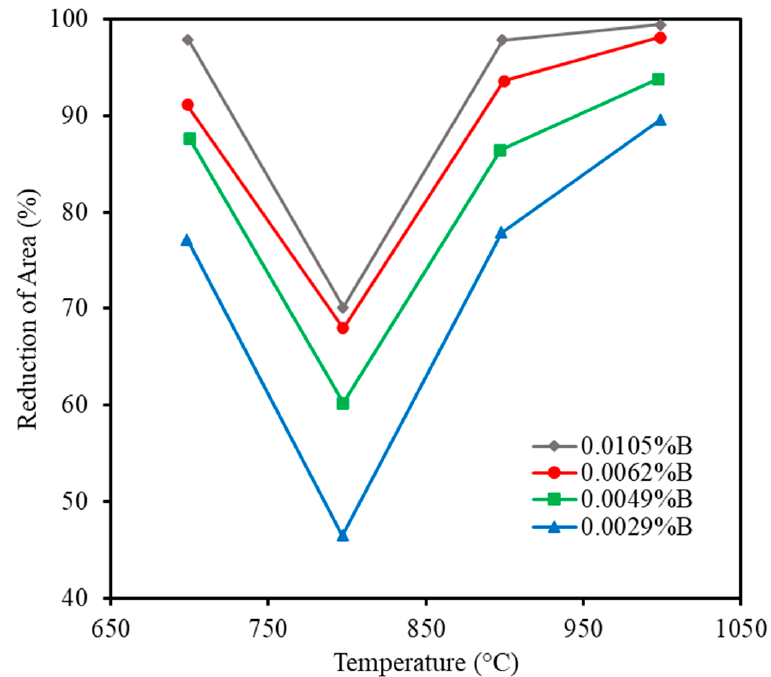
Figure 5. Hot ductility curves for a series of plain C-Mn steels with varying amounts of boron, from 0.0029 to 0.0105%. Increasing the B level causes the ductility to improve. The steels had the following base composition of 0.04% C, 1.6% Mn, 0.025% Al, and 0.0085% N; they were solution-treated at 1100 °C, held there for 5 min, and were then strained to failure at a strain rate of 10 − 3 · s − 1 [23]. Adapted from [23], with permission from Elsevier, 2023.